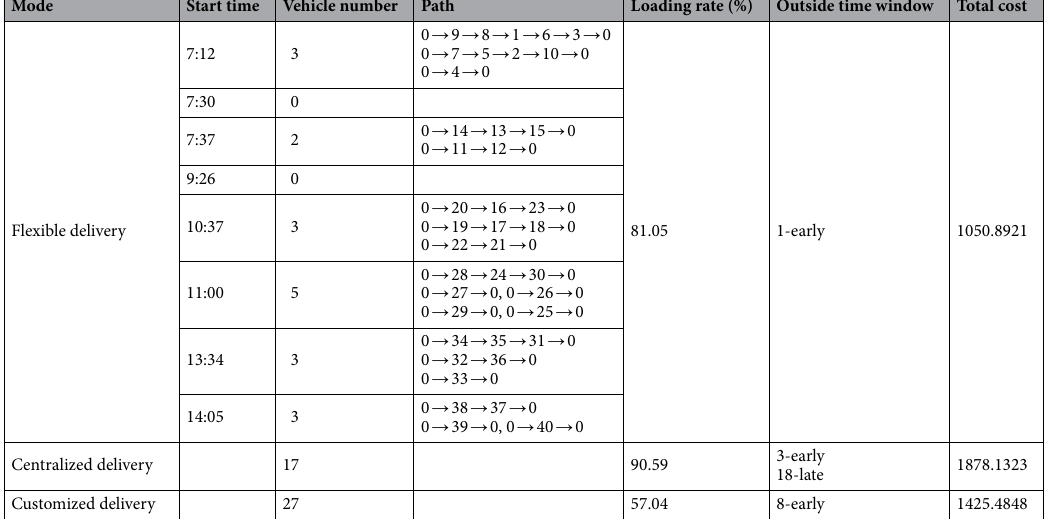
Table 3. Running detail results of simulation experiment and comparison with centralized delivery and customized delivery.